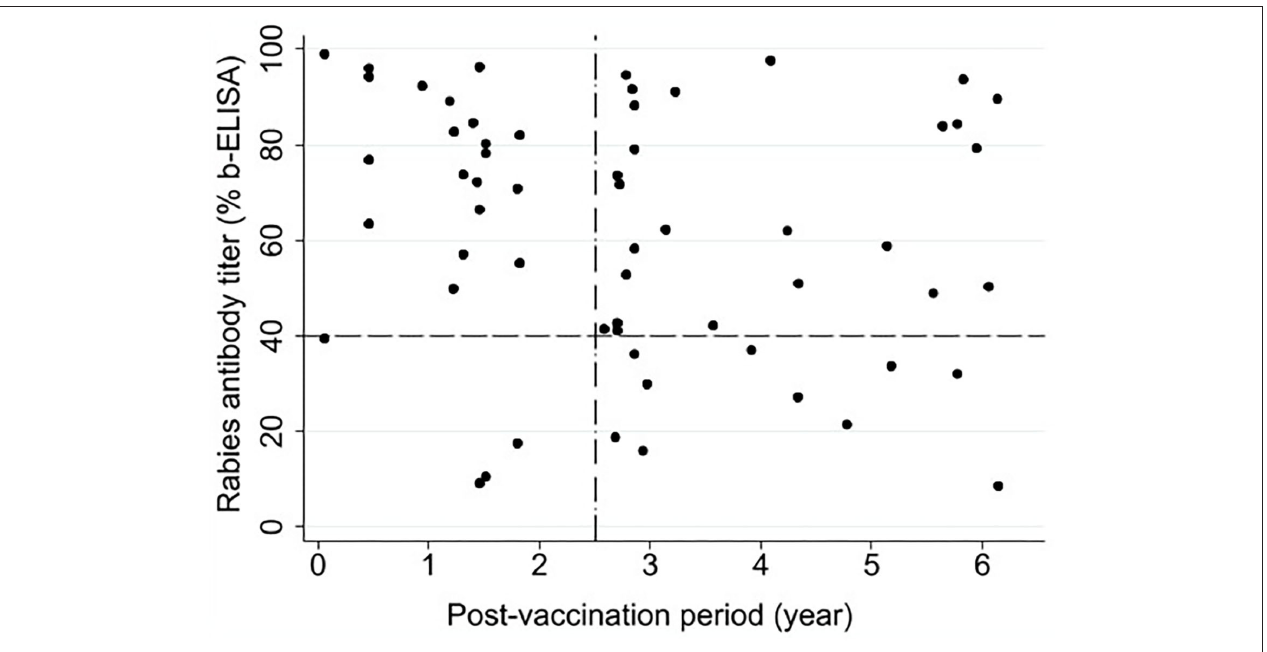
FIGURE 3 | Association between post-vaccination time (year) and rabies antibody titer (% blocking-ELISA) in Hong Kong macaques that received a single dose of Rabisin® rabies vaccine between 2008 and 2016 ( n = 60). The horizontal reference line at 40% represents the cut-off above which sera were considered positive for rabies virus antibodies. The vertical reference line represents the 2.5-year interval recommended for a booster in the current governmental vaccination strategy.